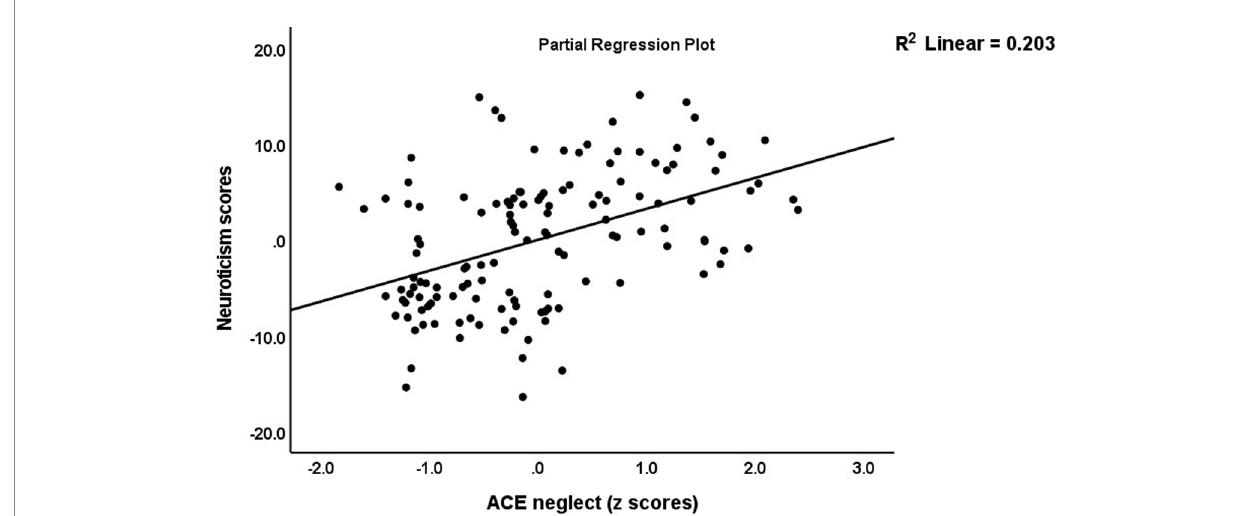
FIGURE 3 Partial regression of neuroticism on neglect adverse childhood experiences (ACE).